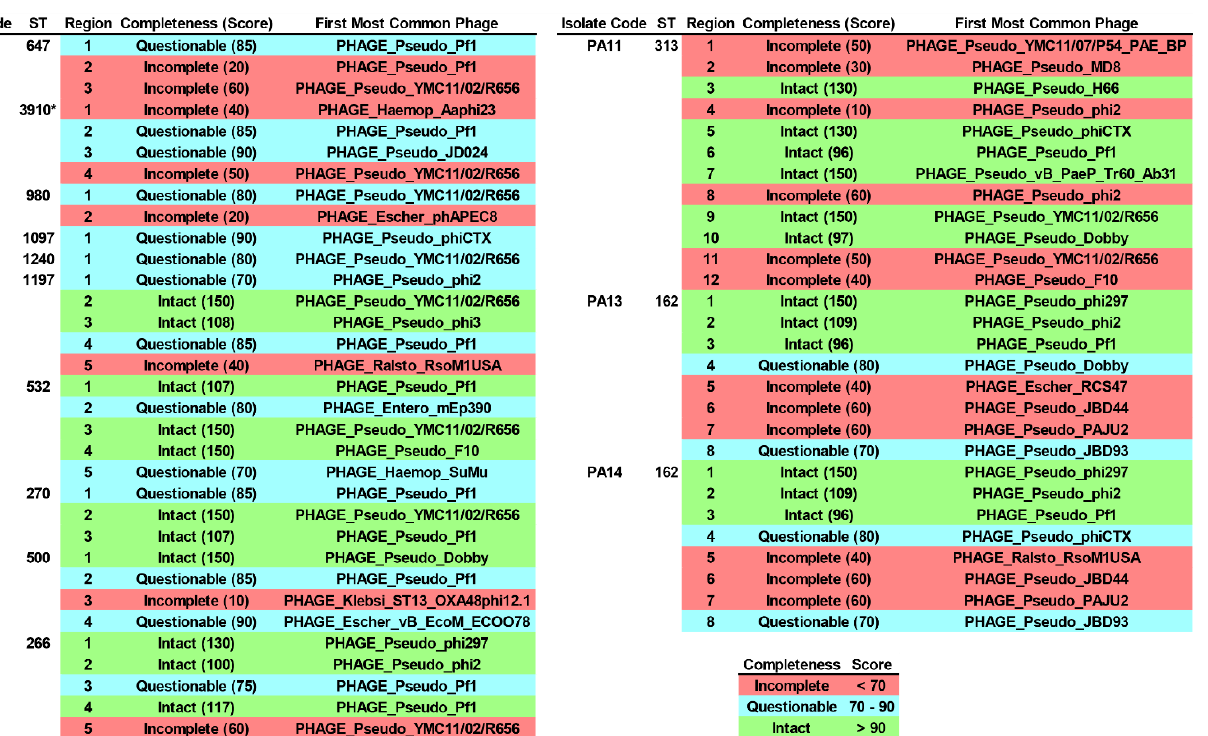
Figure 6. The matrix of pairwise average nucleotide identity (ANI) values and pairwise single nu- cleotide polymorphism (SNP) distance among the colonizing isolates of P. aeruginosa . ST, sequence type. * Novel ST.